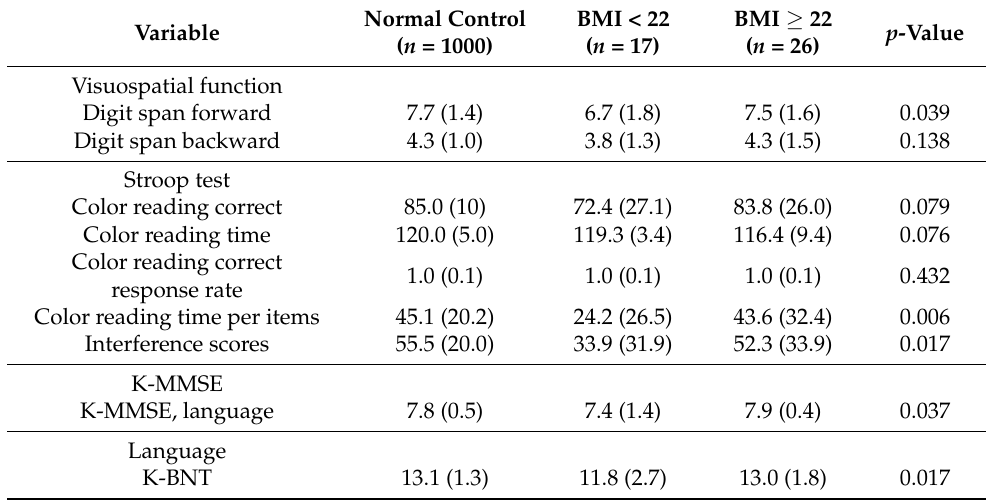
Table 3. Neuropsychological tests related cognitive function.